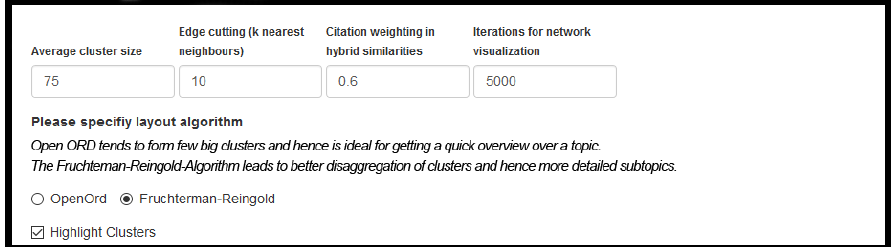
Figure 7. Calculation Parameters (Improved Readability).